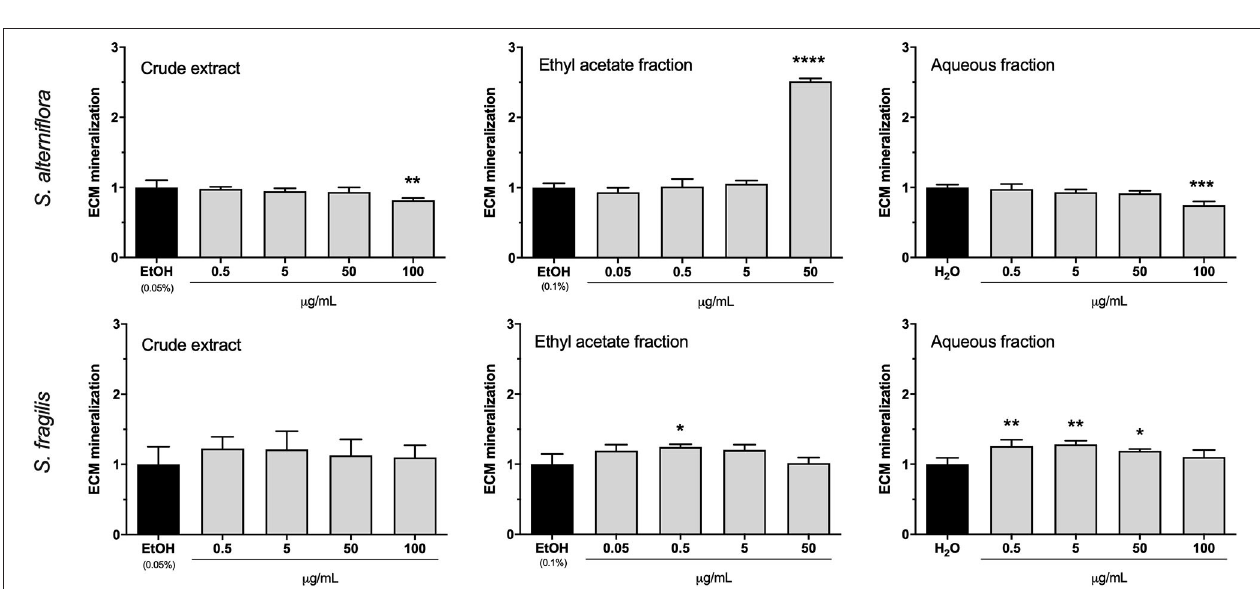
FIGURE 2 | Mineralogenic activity of S. alterniflora (upper panel) and S. fragilis (lower panel) extracts in vitro . VSa13 cells were exposed for 17 days to the crude extracts (0.5, 5, 50, 100 µ g/mL), ethyl acetate fractions (0.05, 0.5, 5, 50 µ g/mL) or aqueous fractions (0.5, 5, 50, 100 µ g/mL) of each plant, or to the respective vehicles (0.05% ethanol, 0.1% ethanol or water). Results are presented as fold-change over the control value (set to 1). Values are presented as mean ± standard deviation ( n = 4). Asterisks indicate values significantly different from the control values (one-way ANOVA followed by Dunnett’s multiple comparison test; * p < 0.05, ** p < 0.01, *** p < 0.001, **** p < 0.0001).